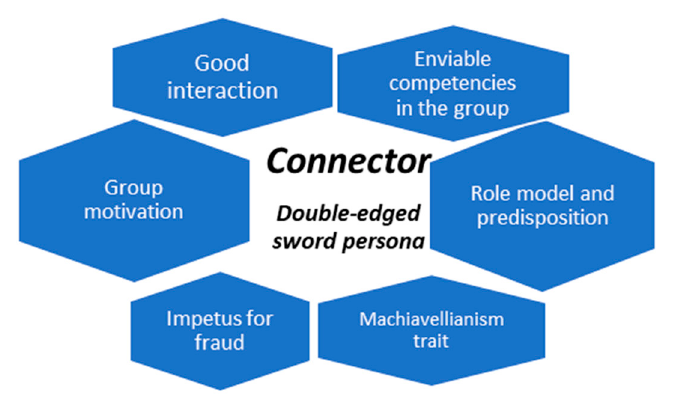
Figure 2. Overall supporting environment of connectors’